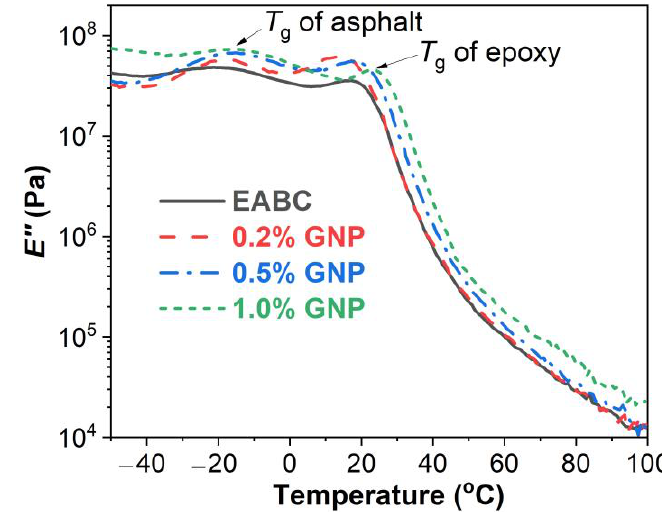
Figure 7. E ″ as a function of GNP-reinforced EABCs. Figure 7. E ” as a function of GNP-reinforced EABCs. Table 5. T g s of epoxy and asphalt and crosslink densities for GNP-reinforced EABCs.